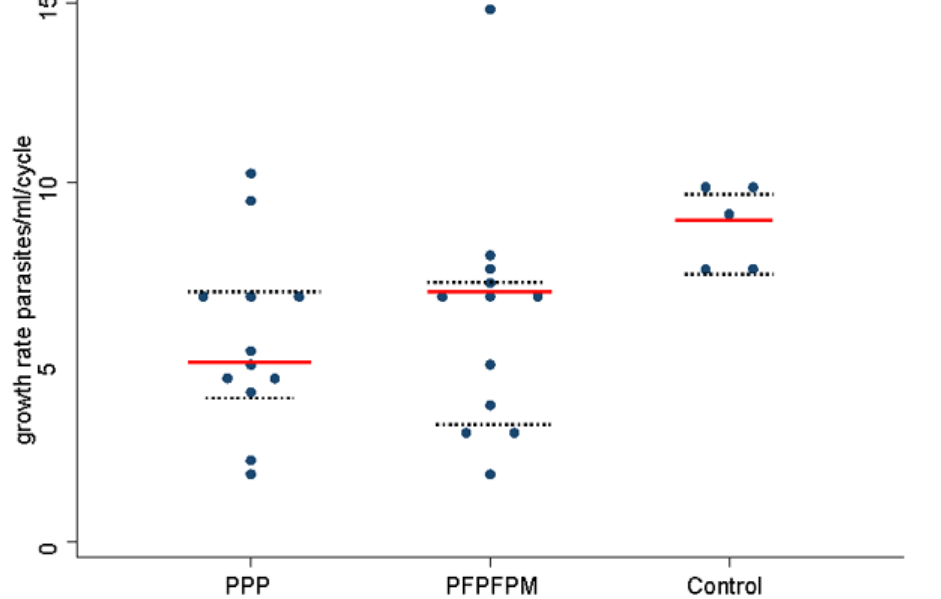
Figure 8. Growth rates, mean and IQ ranges, by group. Growth rate (parasites per mL per cycle) for each individual is shown; the lines represent the group means and inter quartile ranges.